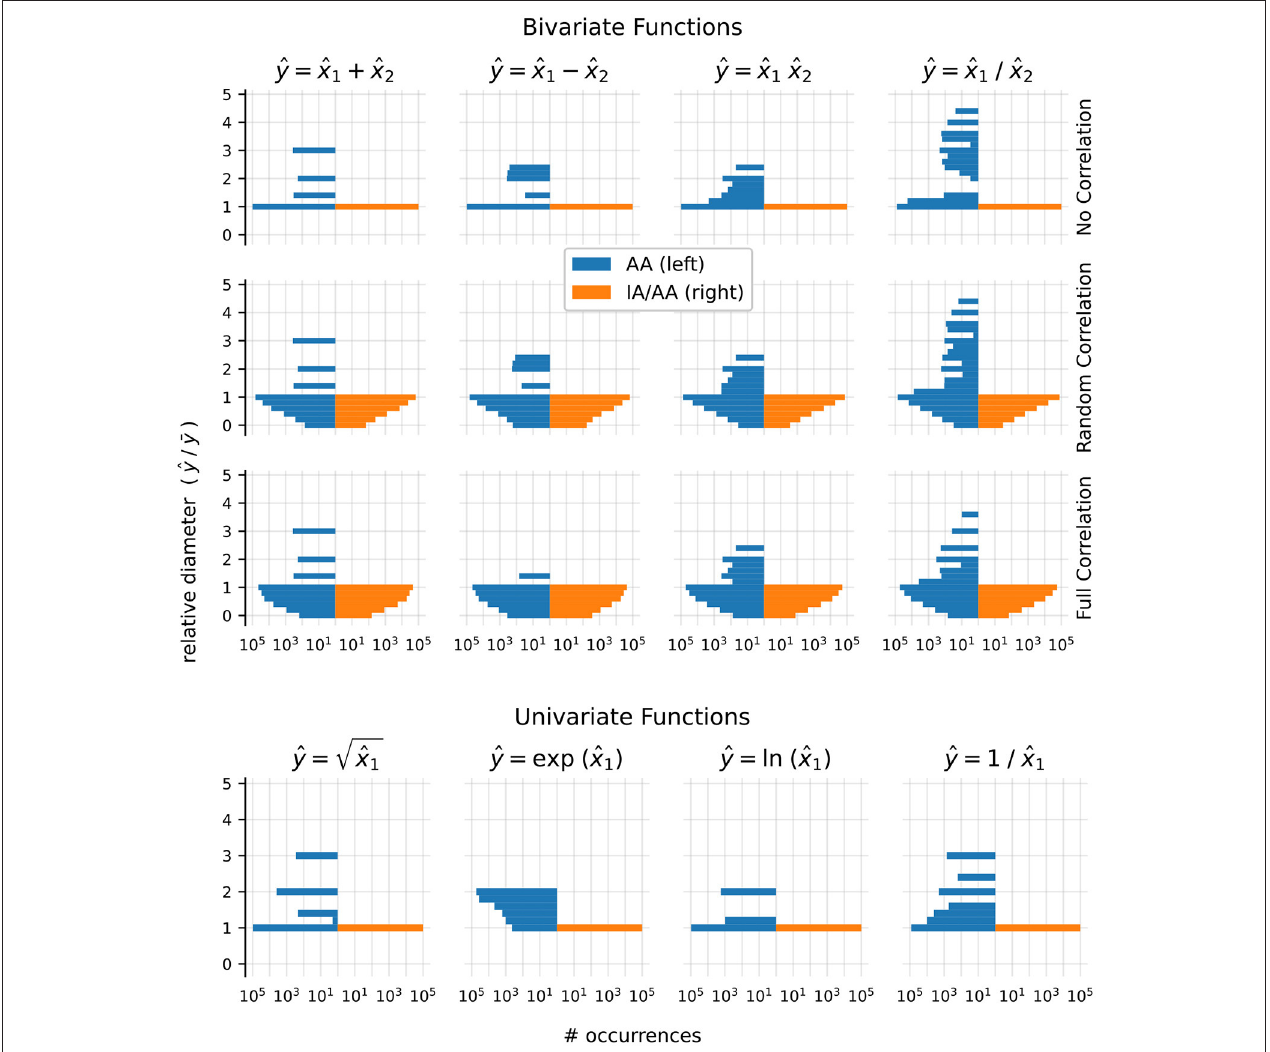
FIGURE 1 | Plots of Arpra diameters relative to IA diameters. The left half of each plot shows results using the plain AA method, while the right side shows the mixed IA/AA method. The top three rows show results for the bivariate functions addition, subtraction, multiplication and division, each with no correlation, random correlation and full correlation of operands. The bottom row shows results for the univariate functions square root, exponential, logarithm and inverse function. Please note the logarithmic scale on the